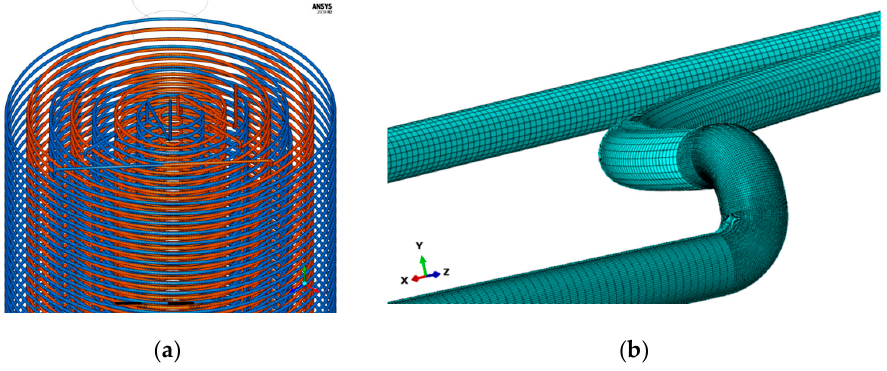
Figure 3. Modeling of coils. ( a ) Reactor coil connection geometry; ( b ) Mesh generation.